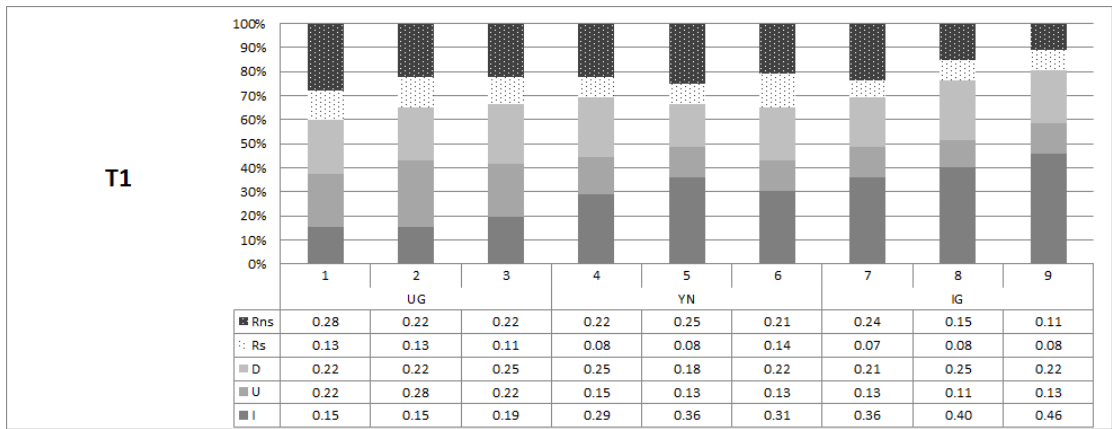
Figure 4. Distribution of types by period in treatment T1. Notes: Each cell entry report the share of choices based on the individual offer profile types: Reactive non-selfserving (Rns), Reactive selfserving (Rs), Adapting Downward (D), Adapting Upward (U), and Immune (I) in Treatment 1.